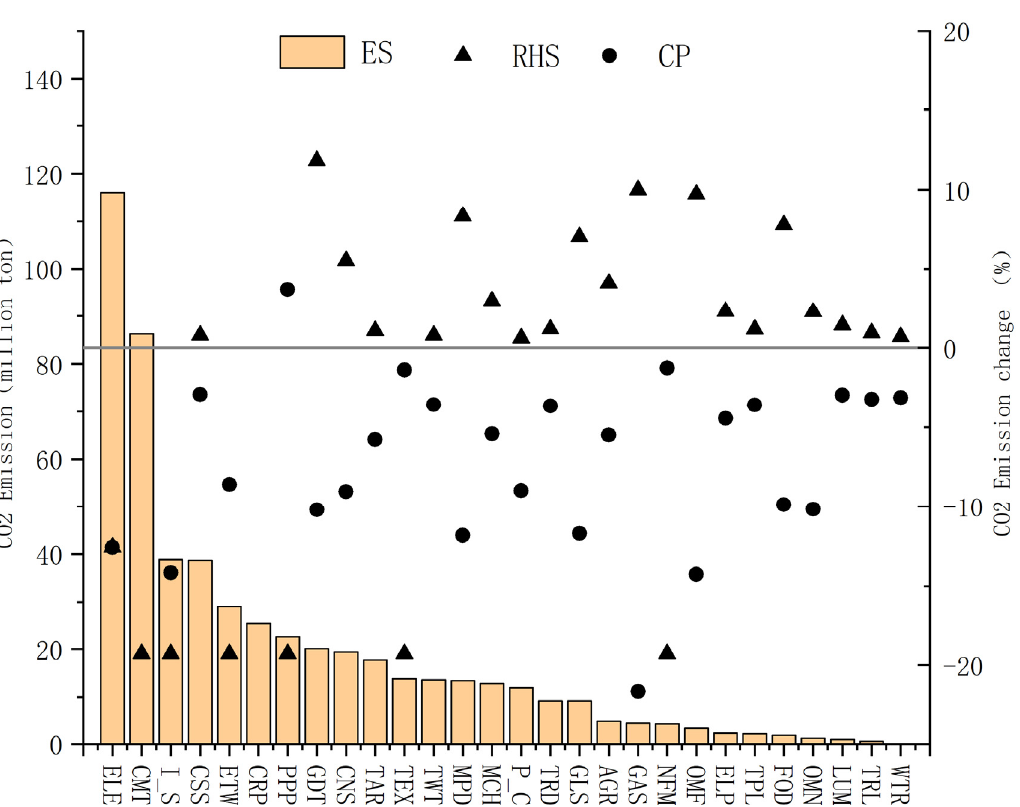
Figure 4. Carbon emissions of ES scenarios in 2035 (Left y-axis) and carbon emissions changes in RHS scenario and CP scenario compared with ES scenario (right y-axis).